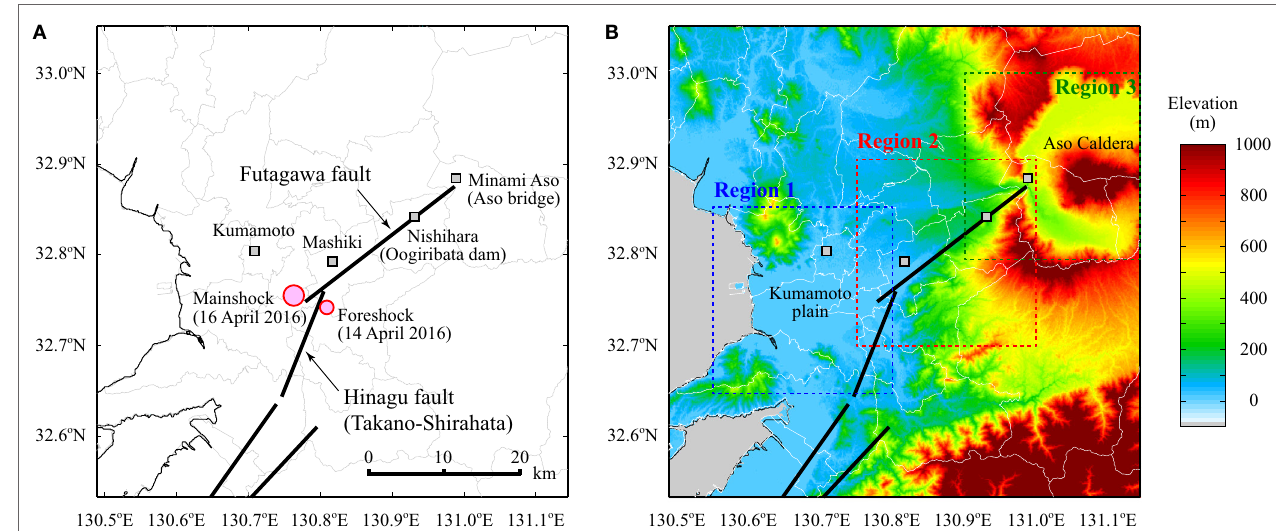
FigUre 1 | (a) Locations of the Futagawa–Hinagu faults. (B) Elevation map of the Kumamoto region.